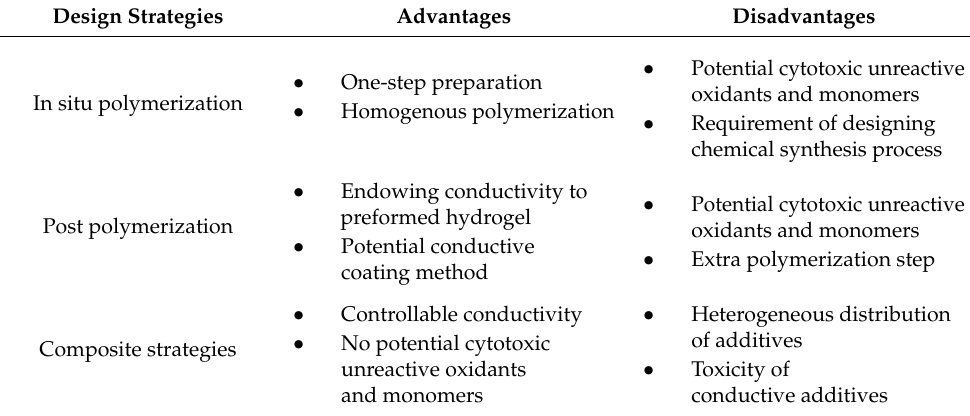
Table 1. Advantages and disadvantages of di ff erent design strategies for preparing conductive hydrogels.